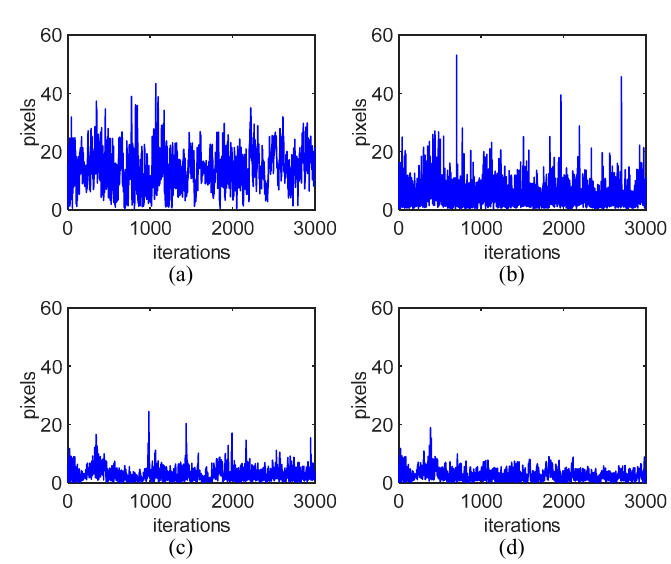
Figure 6. Image error of different strategies in a double leaf rose path. ( a ) Image error of IBUVS. ( b ) Image error of the original PHUVS. ( c ) Image error of the improved PHUVS with the KF method. ( d ) Image error of the improved PHUVS with the KF-SVSF method.